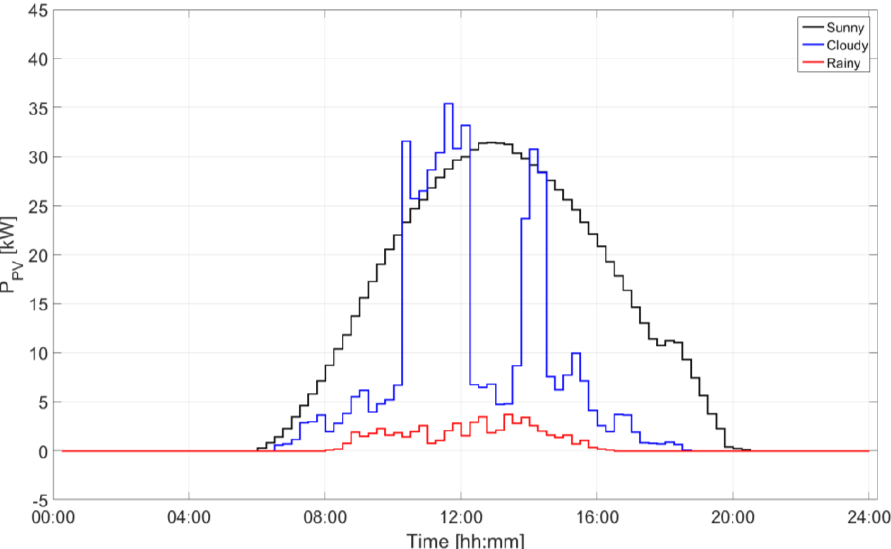
Figure 3. Forecasted output of the photovoltaic system for the three different days. Table 2. Test system. Nominal Parameters.